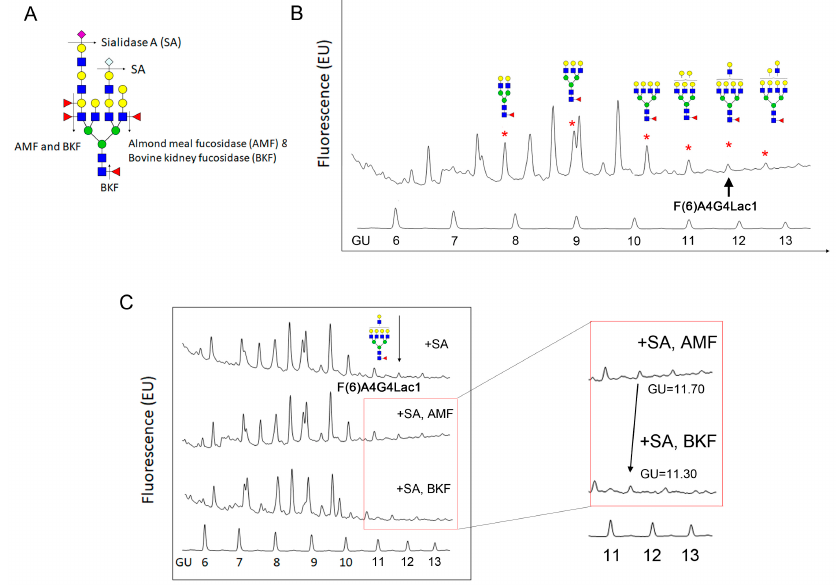
Figure 3. N ‐ glycan sequencing of 4T1 cells. ( A ) Exoglycosidase enzymes used in this experiment. Sialidase A (SA) was used to remove mammalian N ‐ acetyl neuraminic acid (NeuAc) or N ‐ glycolylneuraminic acid (NeuGc); almond meal fucosidase (AMF) was used to remove outer arm